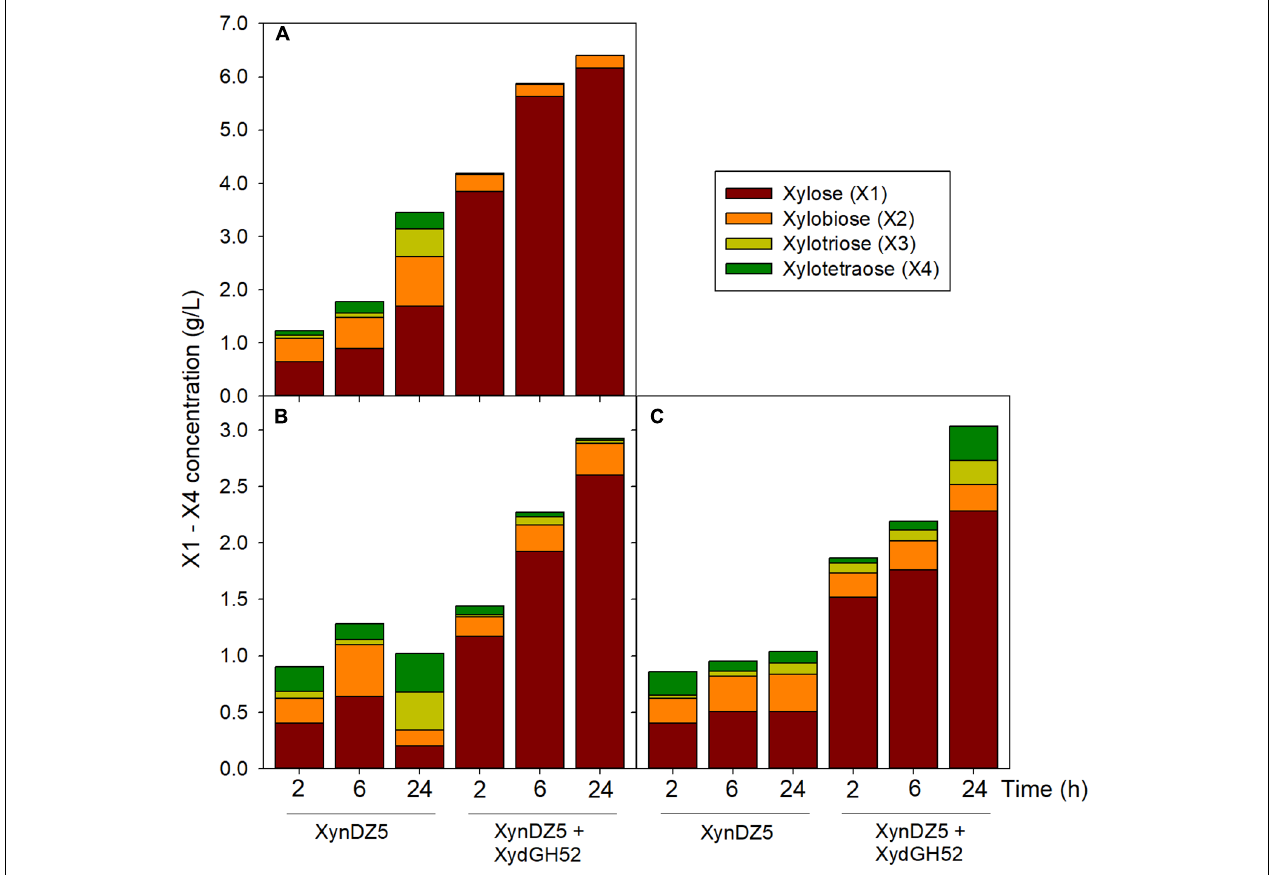
FIGURE 6 | Reaction products following hydrolysis of various xylans with XynDZ5. XynDZ5 was incubated at 65 ◦ C and pH 7, either alone or with the addition of equimolar quantities of GH52 β -xylosidase of Geobacillus sp. SP24 (XydGH52). Samples were withdrawn at the indicated time intervals. Values represent the average of triplicate experiments. Standard deviations ranged between 2.7 and 18.6%. Beechwood xylan (A) , birchwood xylan (B) , oat-spelt xylan (C) .